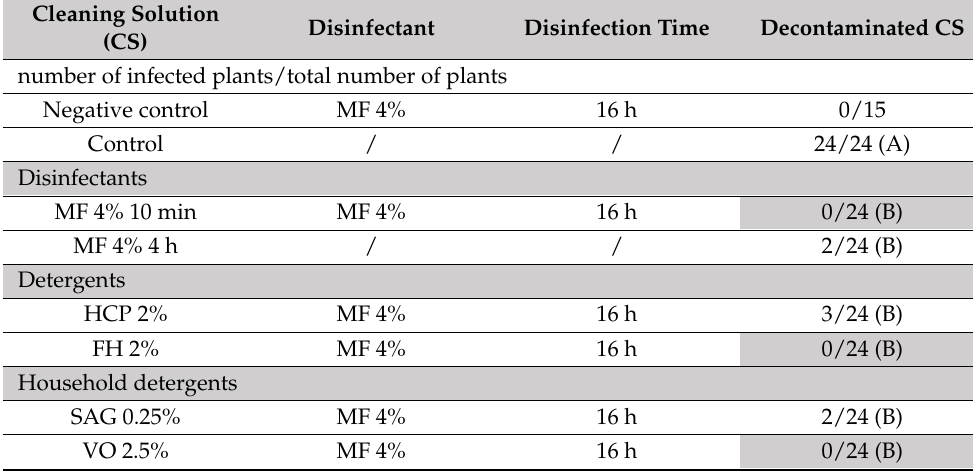
Table 3. Inactivation efficacy of the disinfectant Menno Florades on Tomato brown rugose fruit virus (ToBRFV)-contaminated cleaning solutions measured using bioassays on N. tabacum cv. Xanthi NN. If any plant had at least one ToBRFV-associated necrotic local lesion, the plant was scored as infected. Letters based on pairwise treatment comparisons using Fisher’s exact test (alpha =